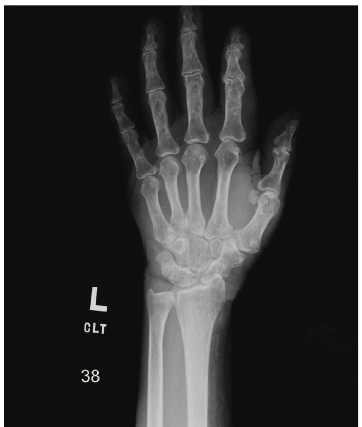
Figure 2: Frontal radiograph of patient 2 demonstrates isolated osseous scaphotrapezial coalition.